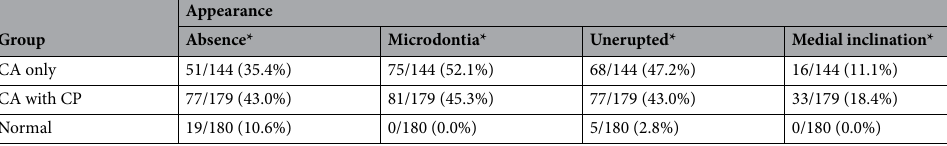
Table 3. Findings of the lateral incisor on the affected side (number of images). *Difference between distributions is significant among three groups (p < 0.001).